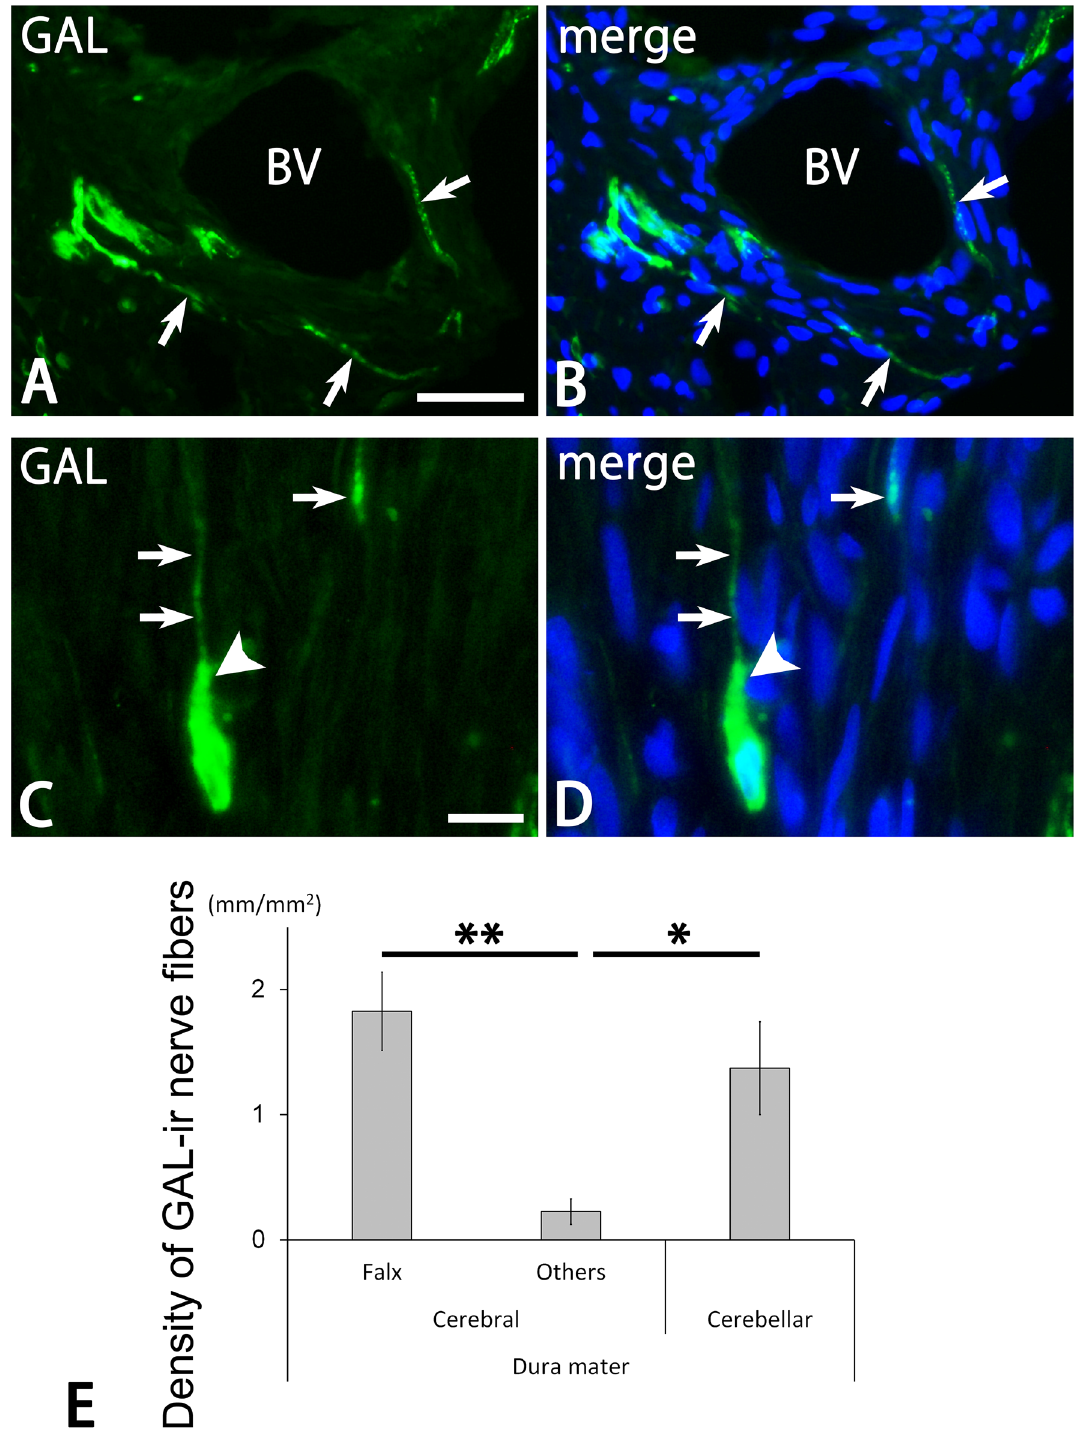
Figure 4. Photomicrographs for GAL ( A – D ) and DAPI ( B , D ) in the dura mater by a conventional fluorescence microscope. Bar graphs indicating the density of GAL-ir nerve fibers in the dura mater. Perivascular nerve fibers with varicosities (arrows in A , B ) contain GAL-immunoreactivity. GAL-ir nerve fibers (arrows in C , D ) are also detected in the vicinity of oblong (arrowheads in C , D ) GAL-ir cells. BV blood vessel. Bar = 50 µm ( A ) and 20 µm ( C ). Panels ( A , B ) and ( C , D ) are at the same magnifications, respectively. The density of GAL-ir nerve fibers in the cerebral falx and cerebellar dura mater is significantly higher than in other portions of the cerebral dura mater (Tukey’s test, **p < 0.01; *p < 0.05). The data were obtained from three sections of the cerebral falx, 12 sections of other portions of the cerebral dura mater, and two sections of the cerebellar dura mater in each of the four